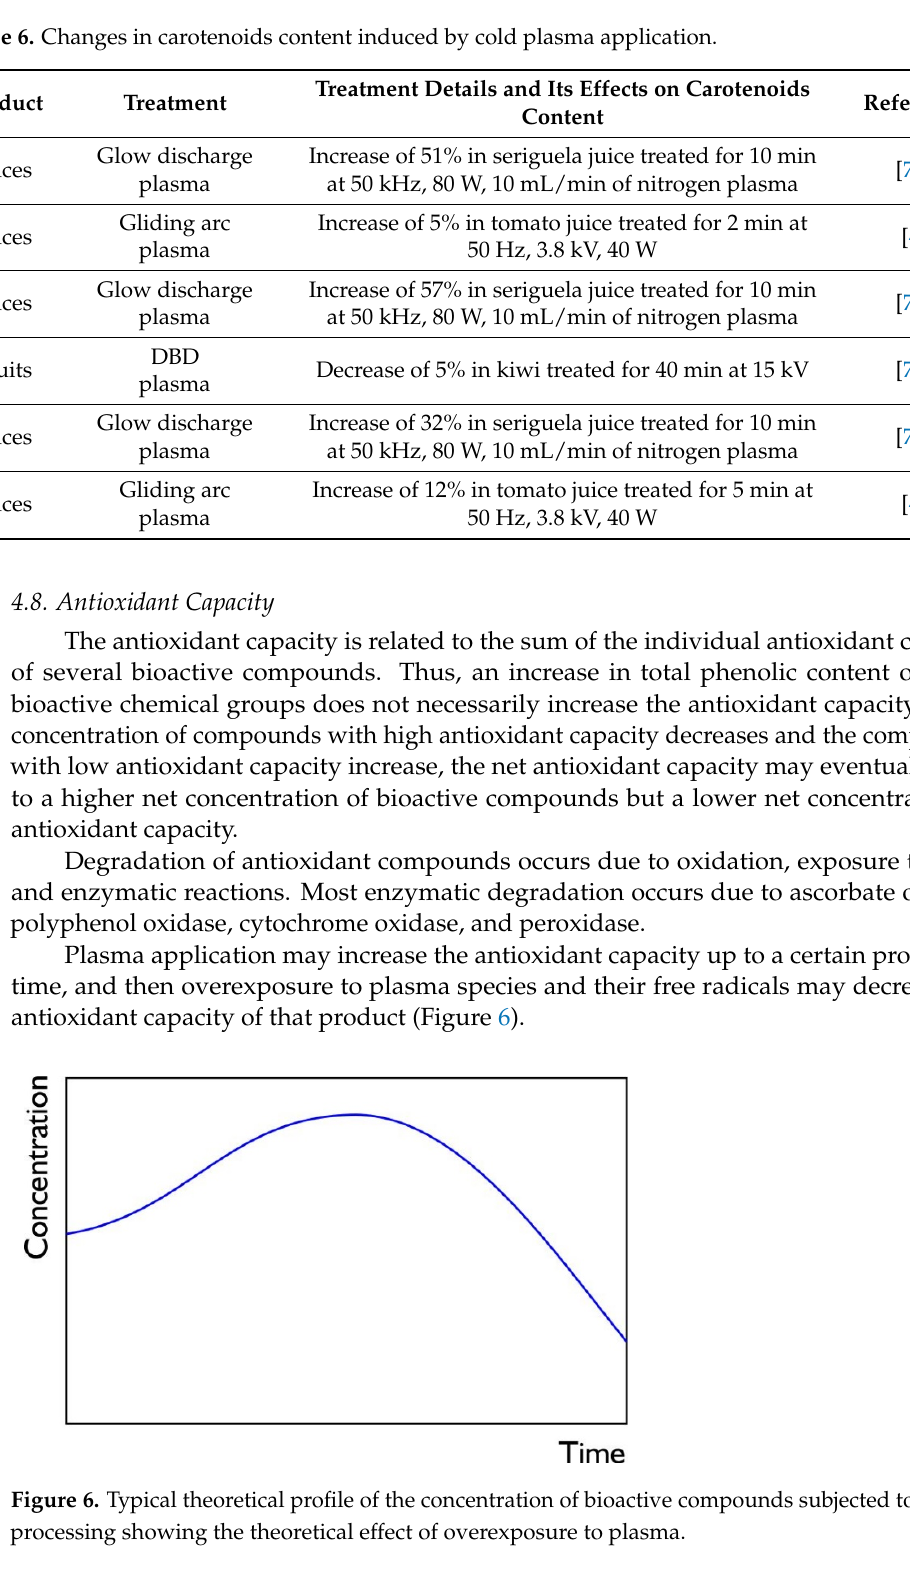
Table 7. Changes in antioxidant capacity induced by cold plasma application.